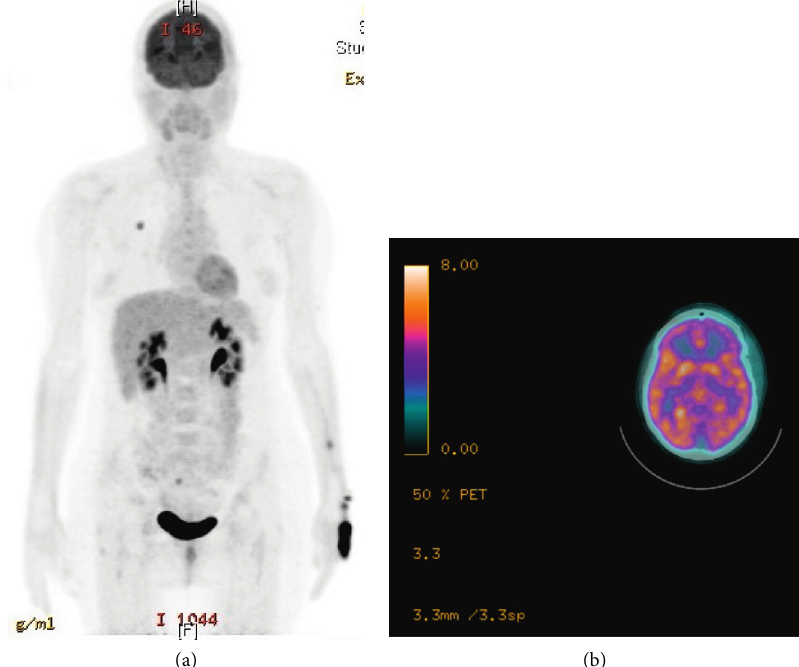
Figure 4: PET scan. Postsurgical changes are present in the left frontal parietal lobe. Punctate hypermetabolic foci are present in both cerebral hemispheres and cerebellum compatible metastatic lesions. There is a 1.2 cm hypermetabolic nodule in the right upper lobe with a max SUV of 4.3.